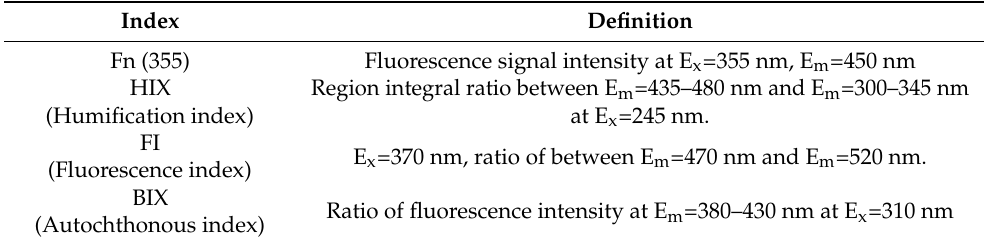
Table 4. Description of fluorescence spectrum